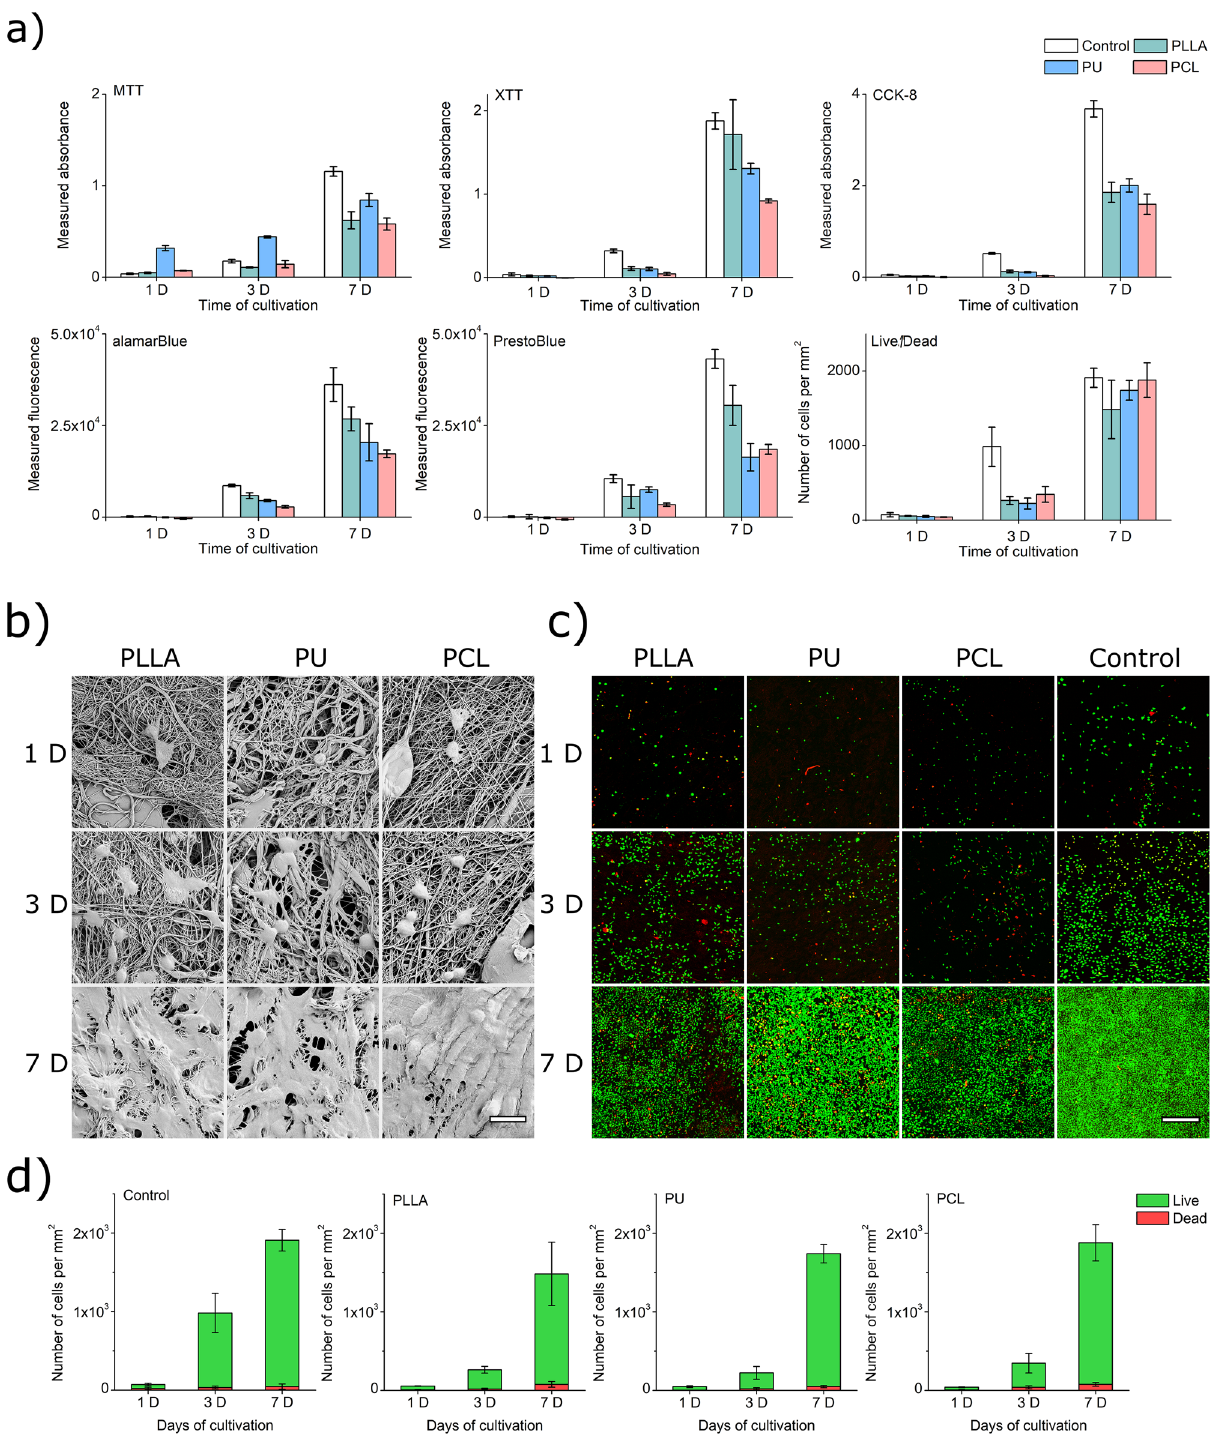
Figure 3. ( a ) Dependency between the result of MTT, XTT, CCK-8, alamarBlue, PrestoBlue, and Live/Dead assay and time of cell cultivation on PLLA, PU, and PCL materials. ( b ) SEM images of L929 cell culture on surfaces of PLLA, PU, and PCL scaffolds after 1 day, 3 days, and 7 days of cultivation. Scale bar represents 20 µm ( c ) CLSM images of L929 cell culture on surfaces of PLLA, PU, and PCL scaffolds after 1, 3, and 7 days of cultivation. Green dots are live cells; red dots are dead cells. The scale bar represents 500 µm. CLSM images of cells on the entire surfaces of the scaffolds are presented in Supplementary Materials (Fig. S4). ( d ) Results of counting live and dead cells in CLSM images of L929 cell culture on surfaces of PLLA, PU, and PCL scaffolds after 1, 3, and 7 days of